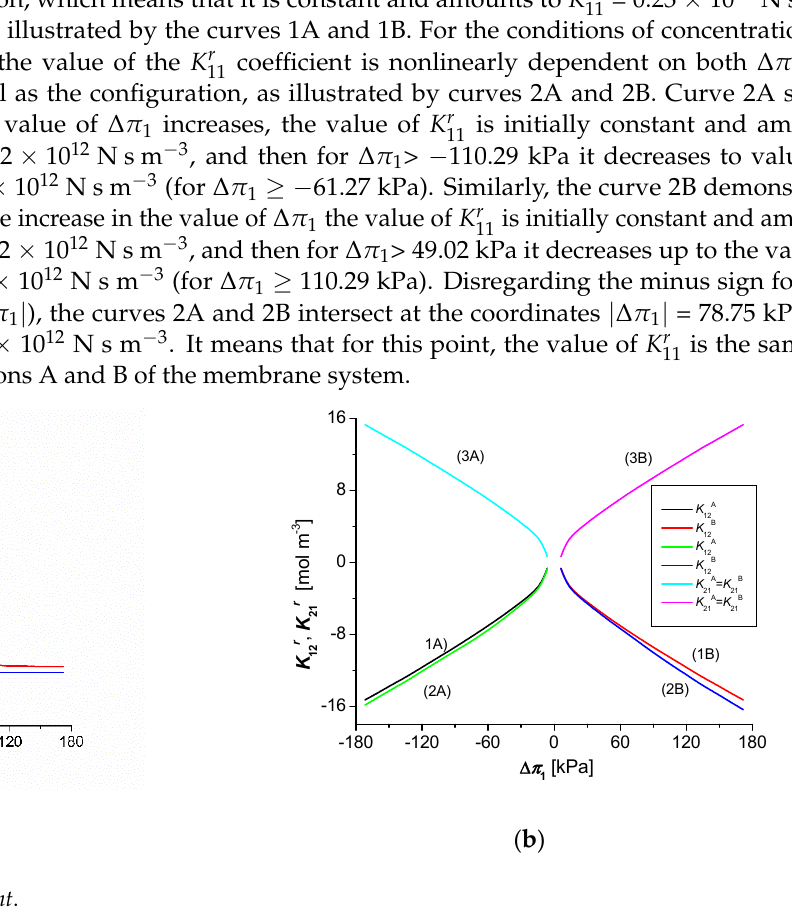
( d ) Figure 5. Coefficients 𝐾 (cid:3036)(cid:3037)(cid:3045) ( i , j ∈ {1, 2, 3}, r = A, B) as functions of glucose osmotic pressure difference ( ∆𝜋 (cid:2869) ) and ∆𝜋 (cid:2870) = 490.2 kPa: 𝐾 (cid:2869)(cid:2869)(cid:3045) ( a ), 𝐾 (cid:2869)(cid:2870)(cid:3045) and 𝐾 (cid:2870)(cid:2869)(cid:3045) ( b ), 𝐾 (cid:2869)(cid:2871)(cid:3045) ( c ), 𝐾 (cid:2870)(cid:2870)(cid:3045) ( d ). . Figure 5b shows the dependencies 𝐾 (cid:2869)(cid:2870)(cid:3045) = f ( ∆𝜋 (cid:2869) , ∆𝜋 (cid:2870) = 490.2 kPa) and 𝐾 (cid:2870)(cid:2869)(cid:3045) = f ( ∆𝜋 (cid:2869) , ∆𝜋 (cid:2870) = 490.2 kPa). Curves 1A and 1B were obtained for the uniformity of the solutions and are symmetrical with respect to the axis passing through the point ∆𝜋 (cid:2869) = 0. Curves 3A and 3B are characterized by symmetry with respect to the axis passing through the point ∆𝜋 (cid:2869) = 0, which illustrate the dependences 𝐾 (cid:2870)(cid:2869)(cid:3045) = f ( ∆𝜋 (cid:2869) , ∆𝜋 (cid:2870) = 490.2 kPa) for the conditions of homogeneity of solutions and concentration polarization. Curves 2A and 2B show a slight asymmetry, which illustrate the dependence 𝐾 (cid:2869)(cid:2870)(cid:3045) = f ( ∆𝜋 (cid:2869) , ∆𝜋 (cid:2870) = 490.2 kPa) for the conditions of concentration polarization. The values of the 𝐾 (cid:2869)(cid:2870)(cid:3045) coefficients are negative for both the uniformity of solutions and concentration polarization conditions. Moreo- ver, the values of the 𝐾 (cid:2869)(cid:2870) (cid:3045) coefficients for the concentration polarization conditions are slightly higher than for the concentration polarization conditions. Figure 5c shows the dependencies 𝐾 (cid:2869)(cid:2871)(cid:3045) = f ( ∆𝜋 (cid:2869) , ∆𝜋 (cid:2870) = 490.2 kPa) and 𝐾 (cid:2871)(cid:2869)(cid:3045) = f ( ∆𝜋 (cid:2869) , ∆𝜋 (cid:2870) = 490.2 kPa). For the homogeneity conditions, the value of the coefficients 𝐾 (cid:2869)(cid:2871)(cid:3045) and 𝐾 (cid:2871)(cid:2869)(cid:3045) is independent of the concentration and configuration and is 𝐾 (cid:2869)(cid:2871)(cid:3045) = 𝐾 (cid:2871)(cid:2869)(cid:3045) = − 0.68 × 10 12 N s mol − 1 . This case is illustrated in Figure 5c by curves 1A and 1B. For the conditions of